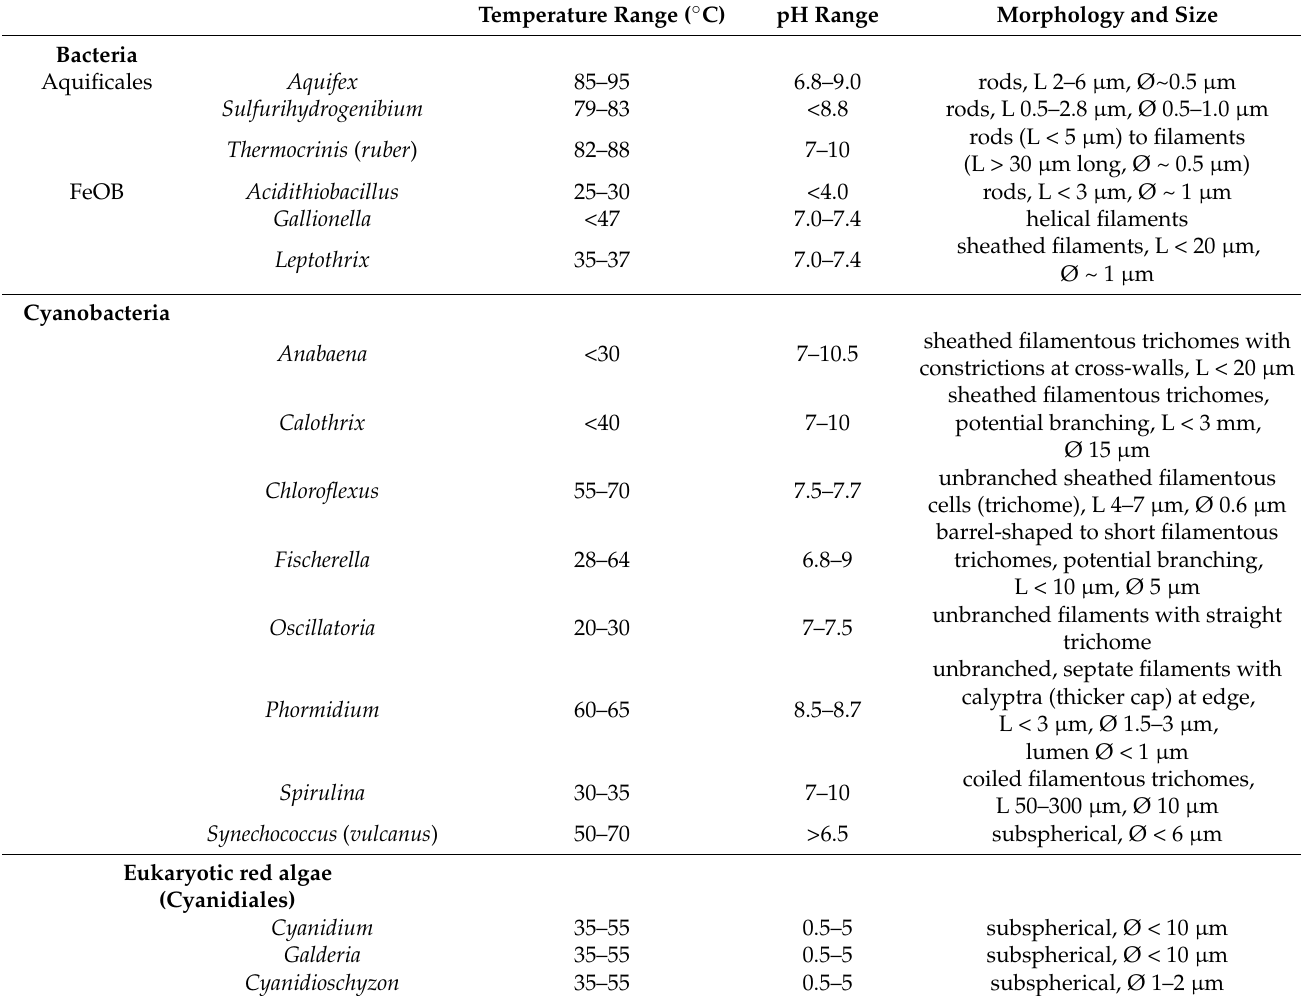
Table 1. Summarized morphological features and ecological (temperature and pH) conditions of cyanobacteria, other bacteria and red algae living in hot spots of Iceland and Yellowstone National Park and microbial cultures of their communities controlled under laboratory conditions; L length, Ø diameter; summary after [38,69,74–87]; * cyanobacteria isolated from the Kr ý suv í k geothermal field after